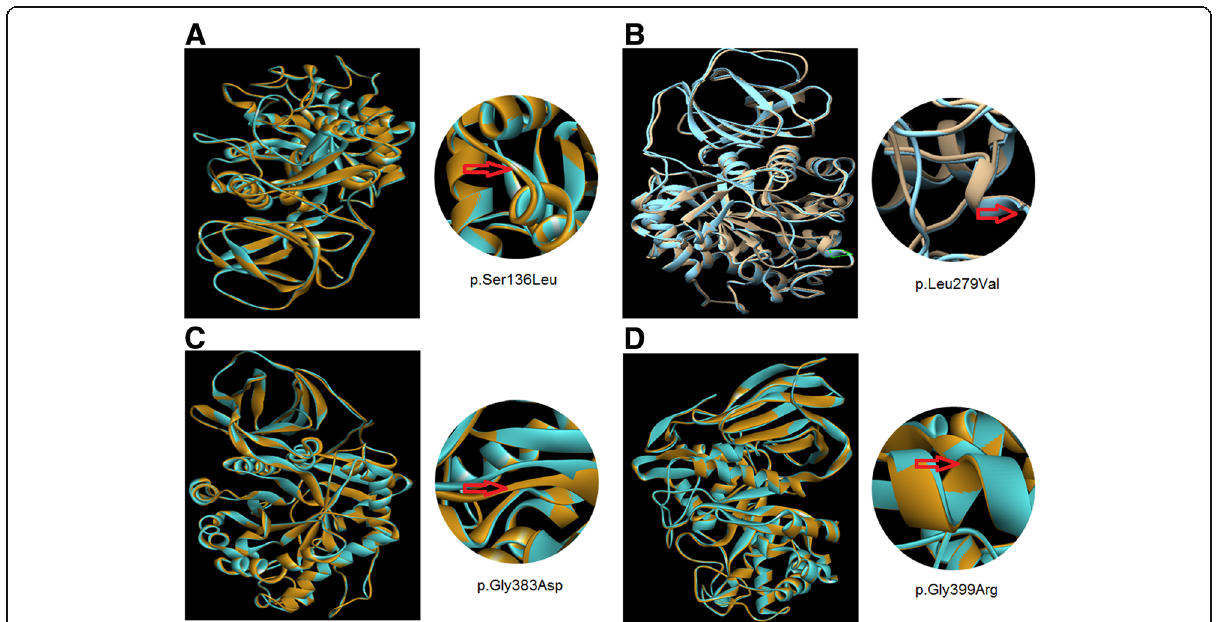
Fig. 3 Homology modeling of novel missense variants identified in the GBA1 gene. The native structure (blue) and mutant structure (brown) are superimposed. a The model of the variant p.Ser136Leu depicting the changes in the loop region joining α 1 and α 1a; at the codon number 136 (TCA-TTA). b The model of the variant p.Leu279Val depicting the destabilization of the normal shape of the active site cavity at the codon number 279 (CTG-GTG). c The model of the variant p.Gly383Asp depicting the conformational changes in the loop regions at the codon number 383 (GGC-GAC). d The model of the variant p.Gly399Arg depicting the conformational changes in the alpha helix at the codon number 399 (GGG-CGG). All the models reveal the conformational changes in the GBA protein